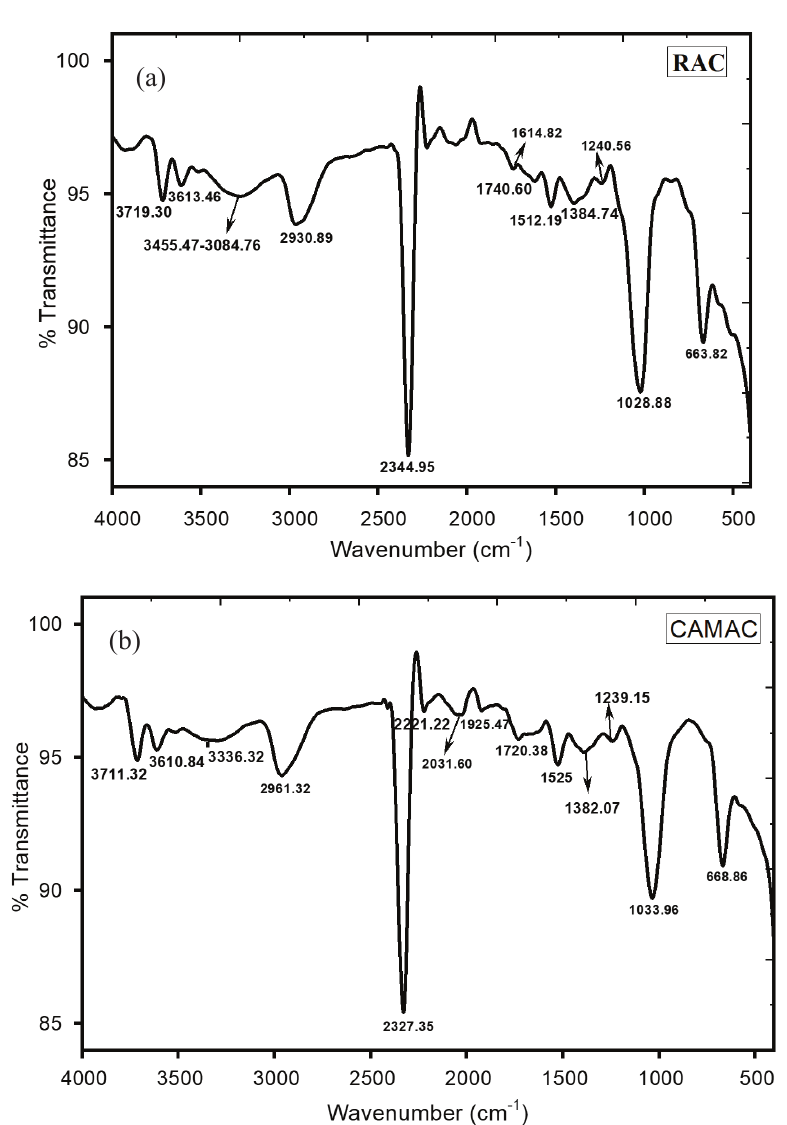
Fig. 1 – FT-IR spectrum of (a) raw Acorus calamus (RAC), (b) citric acid modified Acorus calamus